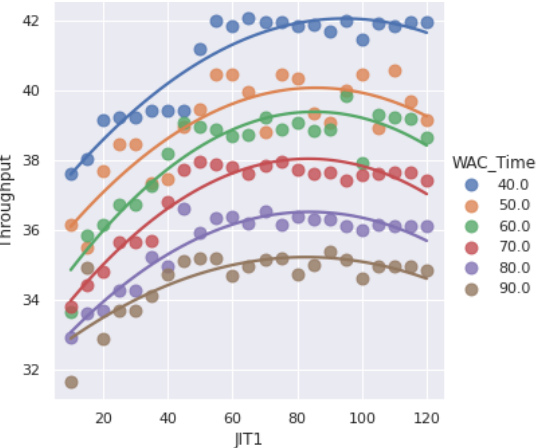
Figure 9. Throughput against JIT1 with different WAC time (recipe_time = 180).